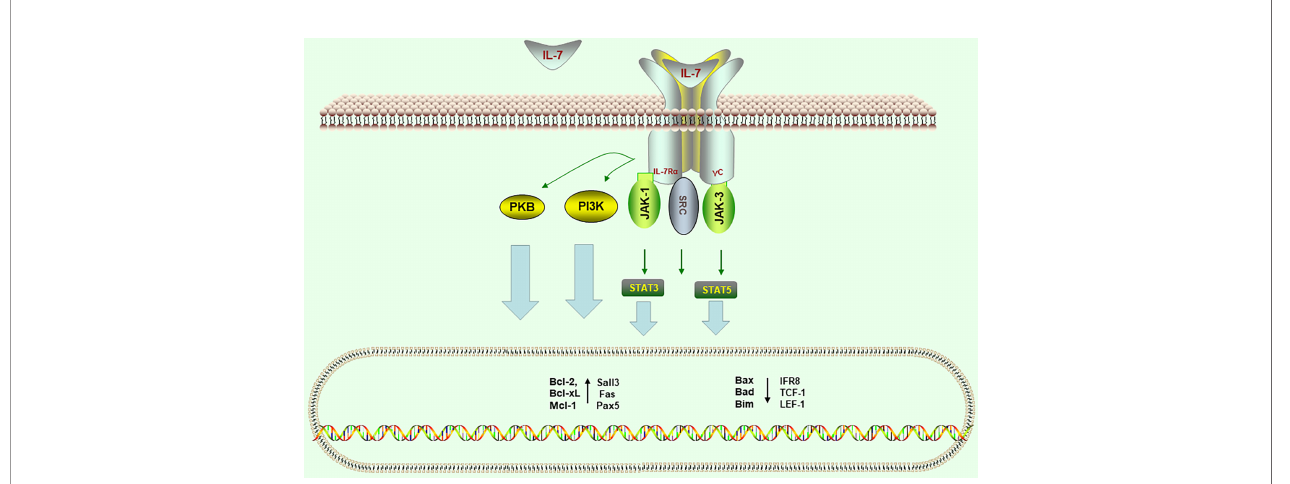
FIGURE 1 | Signal transduction pathways of interleukin-7 receptor (IL-7R). Downstream signaling pathways induced by IL-7 involve Janus kinase 1 (Jak1), Jak3 (through the g-chain), Src kinases, phosphatidylinositol-3 kinase (PI3K), phosphokinase B (PKB), STAT3 (signal transducer and activator of transcription 3), and STAT5. Signal transduction induces changes of gene expression levels in the nucleus, including promoting anti-apoptotic factors (such as Bcl-2, Bcl-xL, and Mcl-1) and inhibition of pro-apoptotic factors (such as Bax, Bad, and